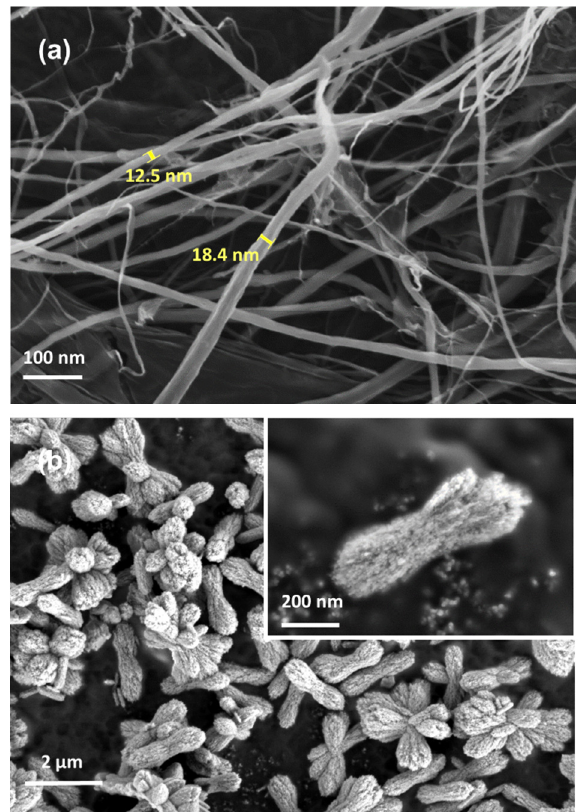
Figure 1. Micrograph images of ( a ) isolated and defibrillated cellulose and ( b ) synthesized CaCO 3 by field emission scanning electron microscope (FESEM) analysis (inset shows the magnified image).